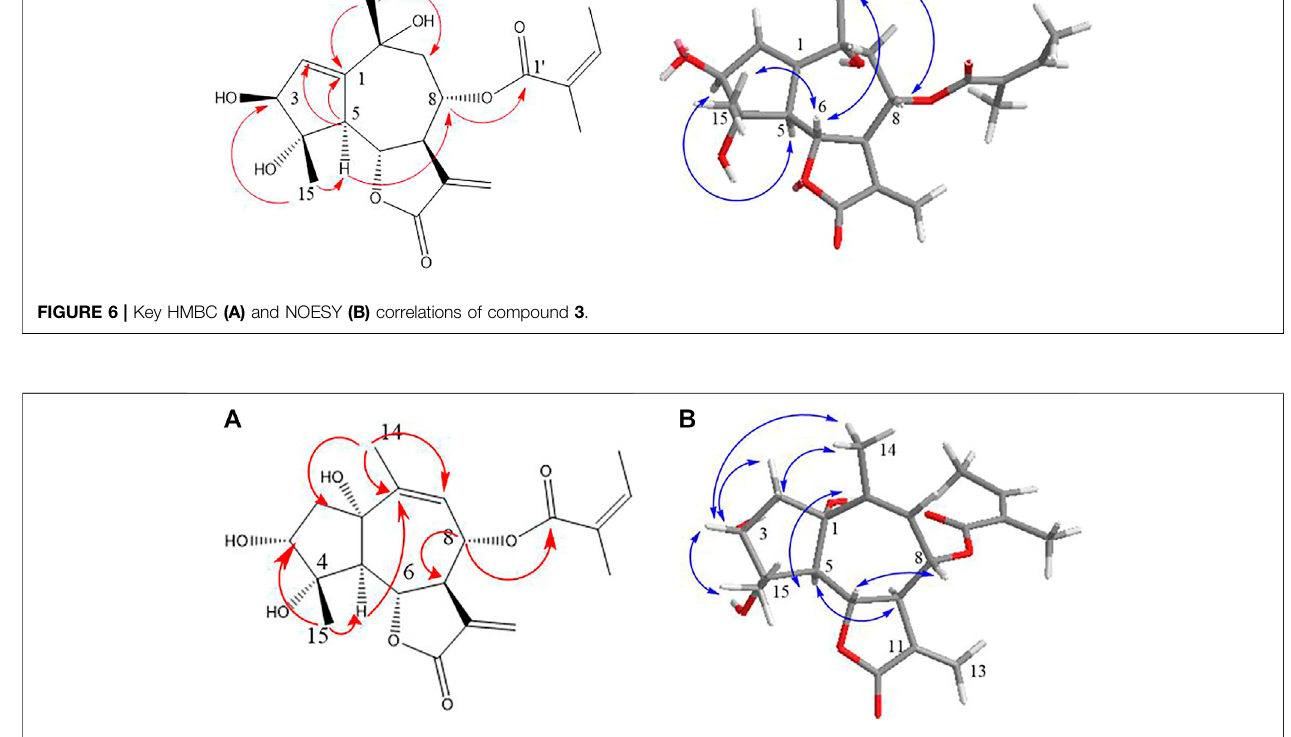
FIGURE 7 | Key HMBC (A) and NOESY (B) correlations of compound 4 .